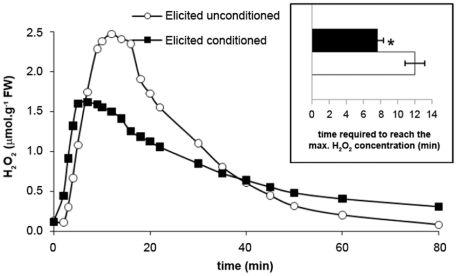
GG-induced oxidative burst in conditioned and unconditioned L. digitata sporophytes.Sporophytes were elicited with GGs in seawater and the concentration of H2O2 was recorded. Experiments were replicated three times and a typical result is shown. Inset: Means and standard errors (n = 3) of the time required to reach the maximum of H2O2 concentrations in the medium after elicitation. The two means were significantly different for conditioned (black bar) and unconditioned (white bar) L. digitata sporophytes (t test: *, P≤0.05).